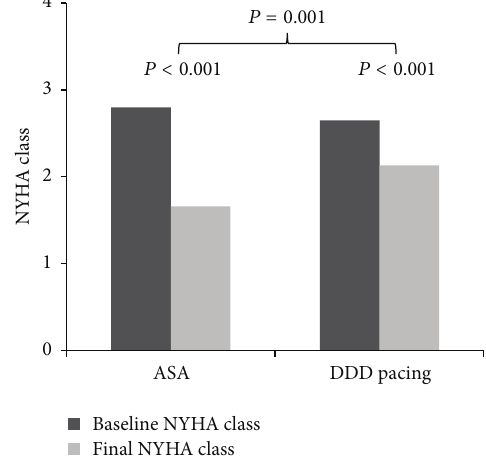
Figure 2: ASA—alcohol septal ablation and DDD pacing—dual chamber